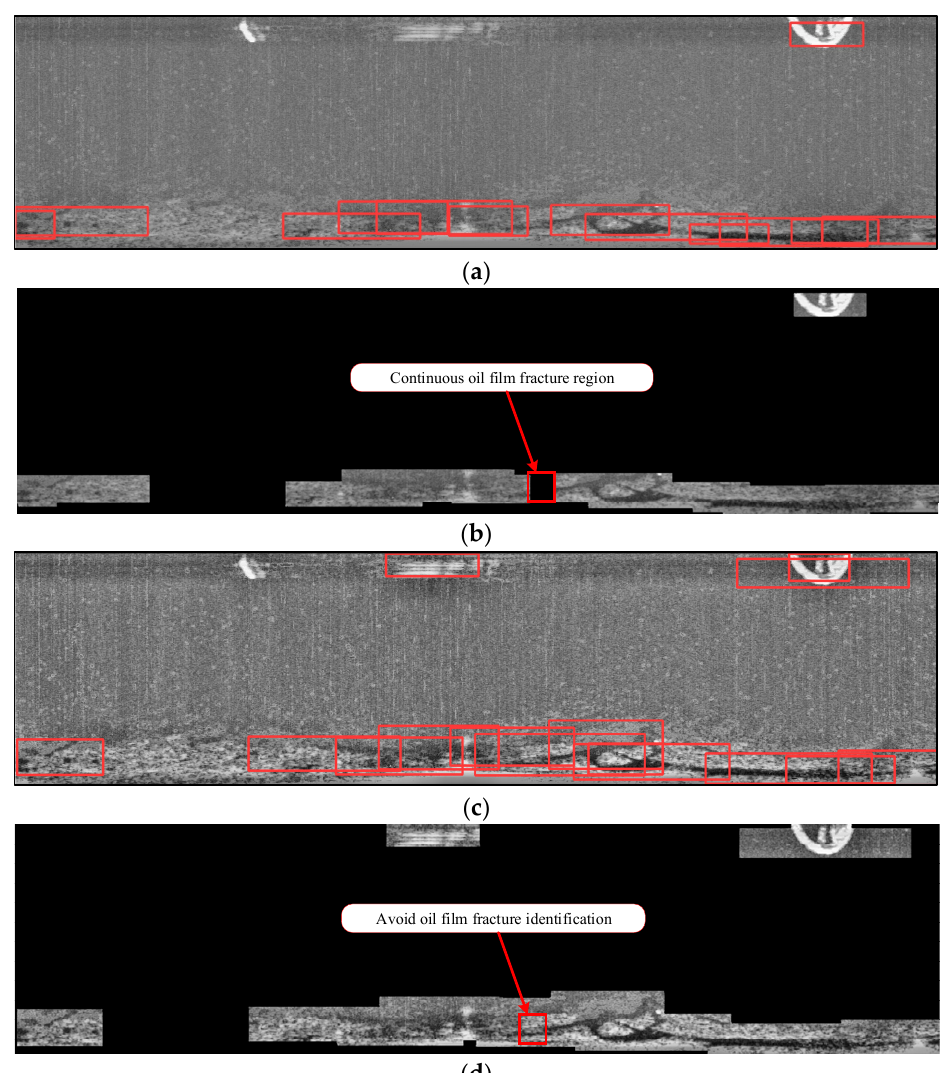
Figure 15. The influence of contrast enhancement on oil film detection. ( a ) Oil spill detection using trained model of gray correction images; ( b ) The effective oil spill regions extraction of ( a ); ( c ) Oil spill detection using trained model of contrast enhancement images; ( d ) The effective oil spill regions extraction of ( c ).